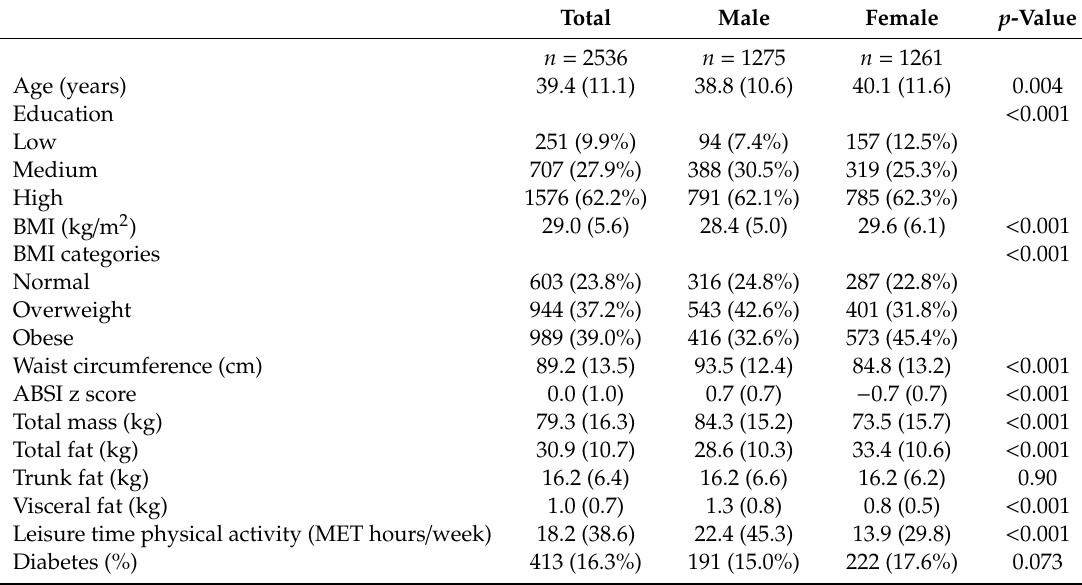
Table 1. Sample characteristics by